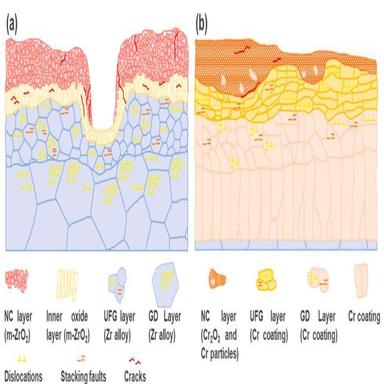
Schematic diagrams of the cross-sectional microstructures induced by the fretting corrosion at 20 Hz in PWR water: (a) Zr alloy cladding, (b) Cr-coated Zr alloy cladding.